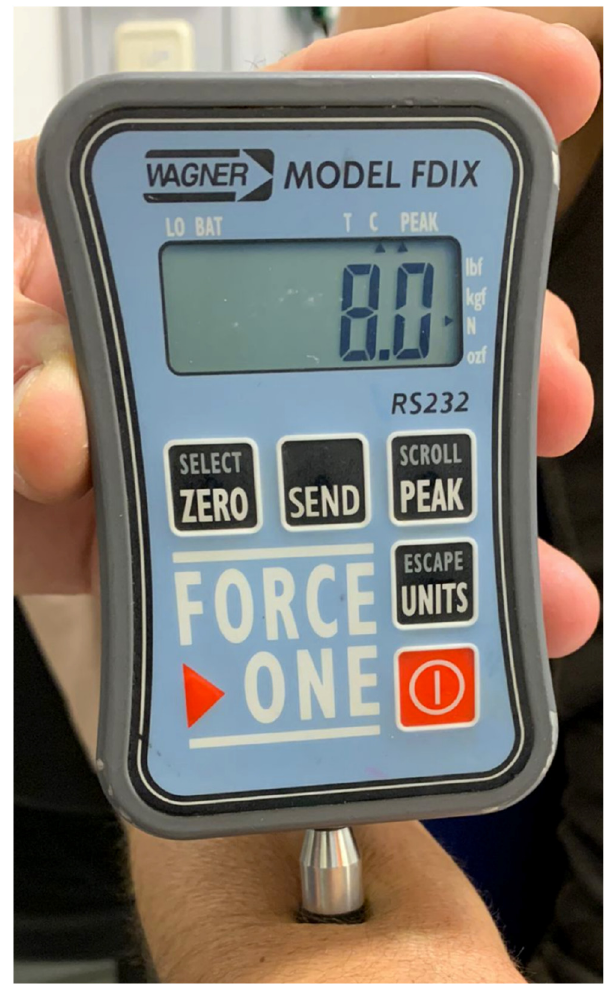
Figure 1. Assessment of pressure pain thresholds.